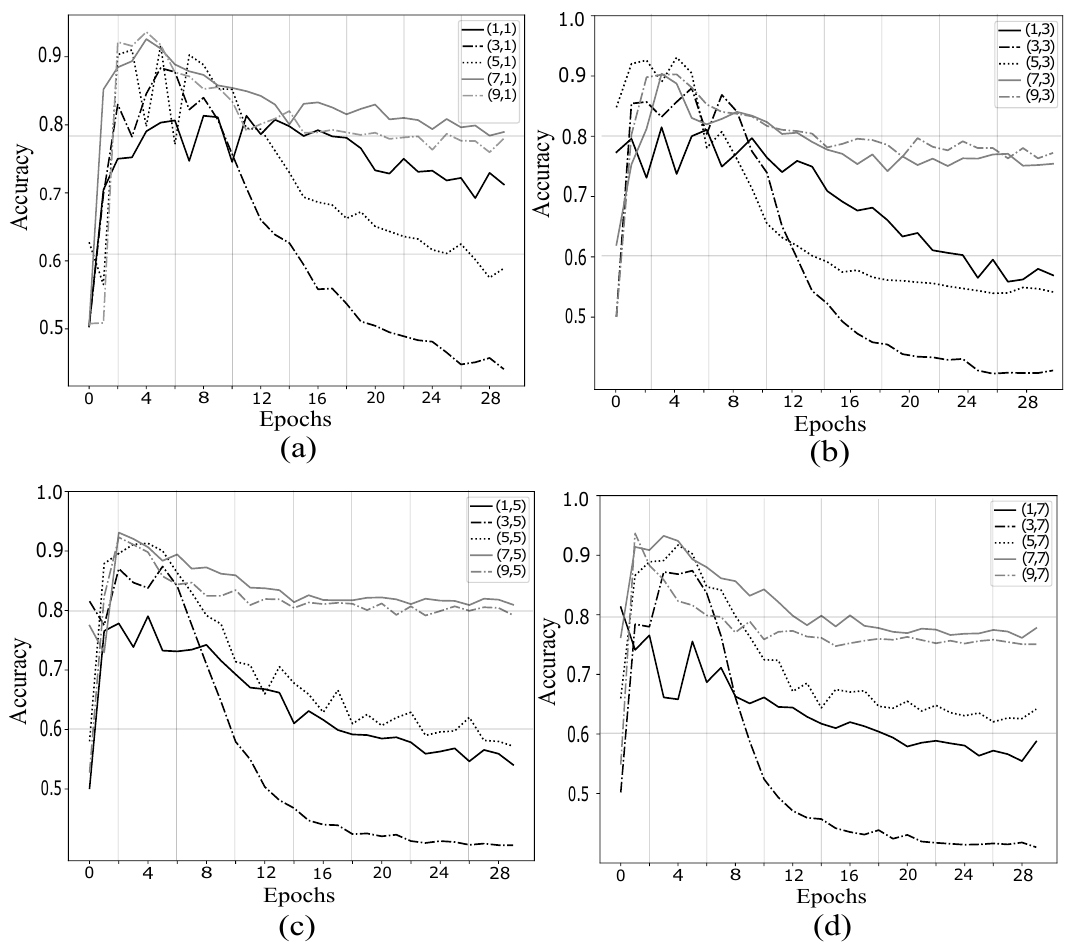
Figure 7. Analysis of kernel size in first convolutional layer: ( a ) (i,1); ( b ) (i,3); ( c ) (i,5); and ( d ) (i,7). The kernel size (7,5) in ( c ) presented less overfitting and major classification